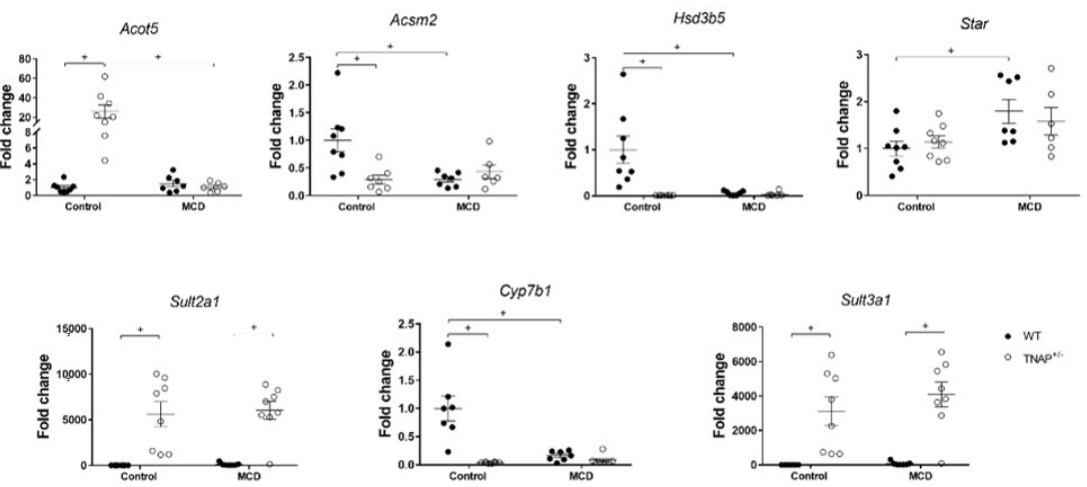
Figure 6. Hepatic expression of genes related to fatty and biliary acid metabolism in wild type (WT) and TNAP heterozygous mice (TNAP +/ − ) fed a control diet (10% w/w fat) normalized expression of qRT-PCR data are shown. + p <